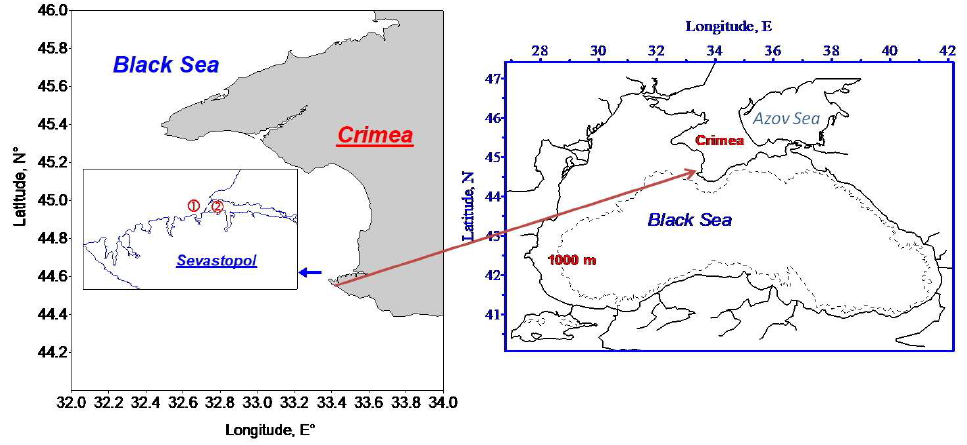
Figure 1. Map of the sampling stations: 1—the exit from the Quarantine Bay (St.1); 2—Sevastopol Bay (St. 2).